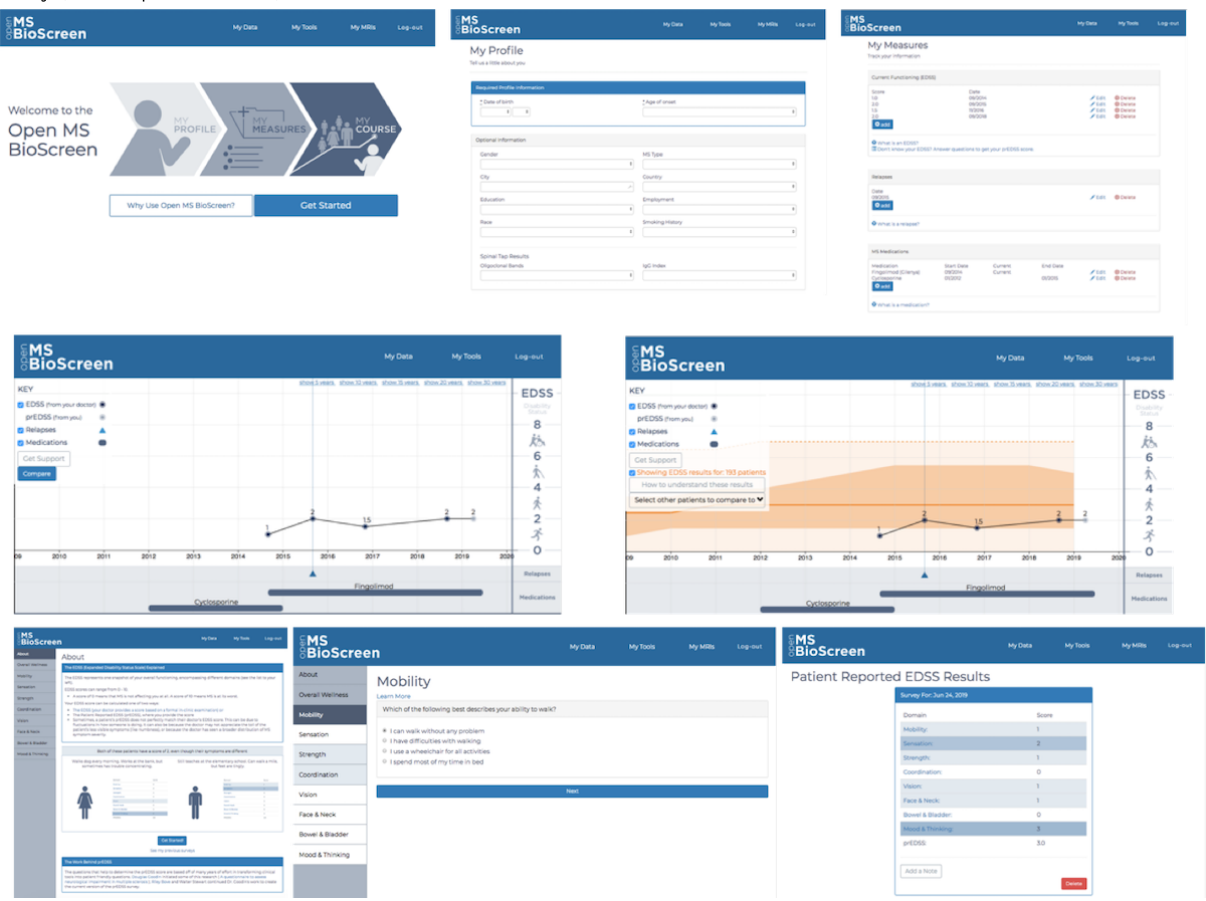
Figure 4. Phase III: Implementation screenshots of Open MS BioScreen’s initial minimally viable product. Top panel: landing page and initial data entry tools. Middle panel: the longitudinal multiple sclerosis course visualization tool, without a contextualization tool. Bottom panel: the patient-reported expanded disability status scale tool, whose development occurred as part of Open MS BioScreen and whose formal clinical validation is reported separately (manuscript under